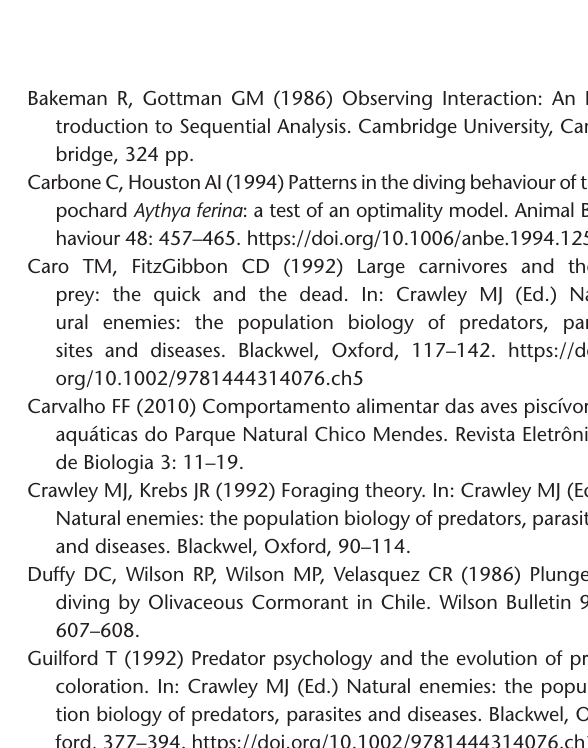
Figure 2. Relationship between dive duration and stealing